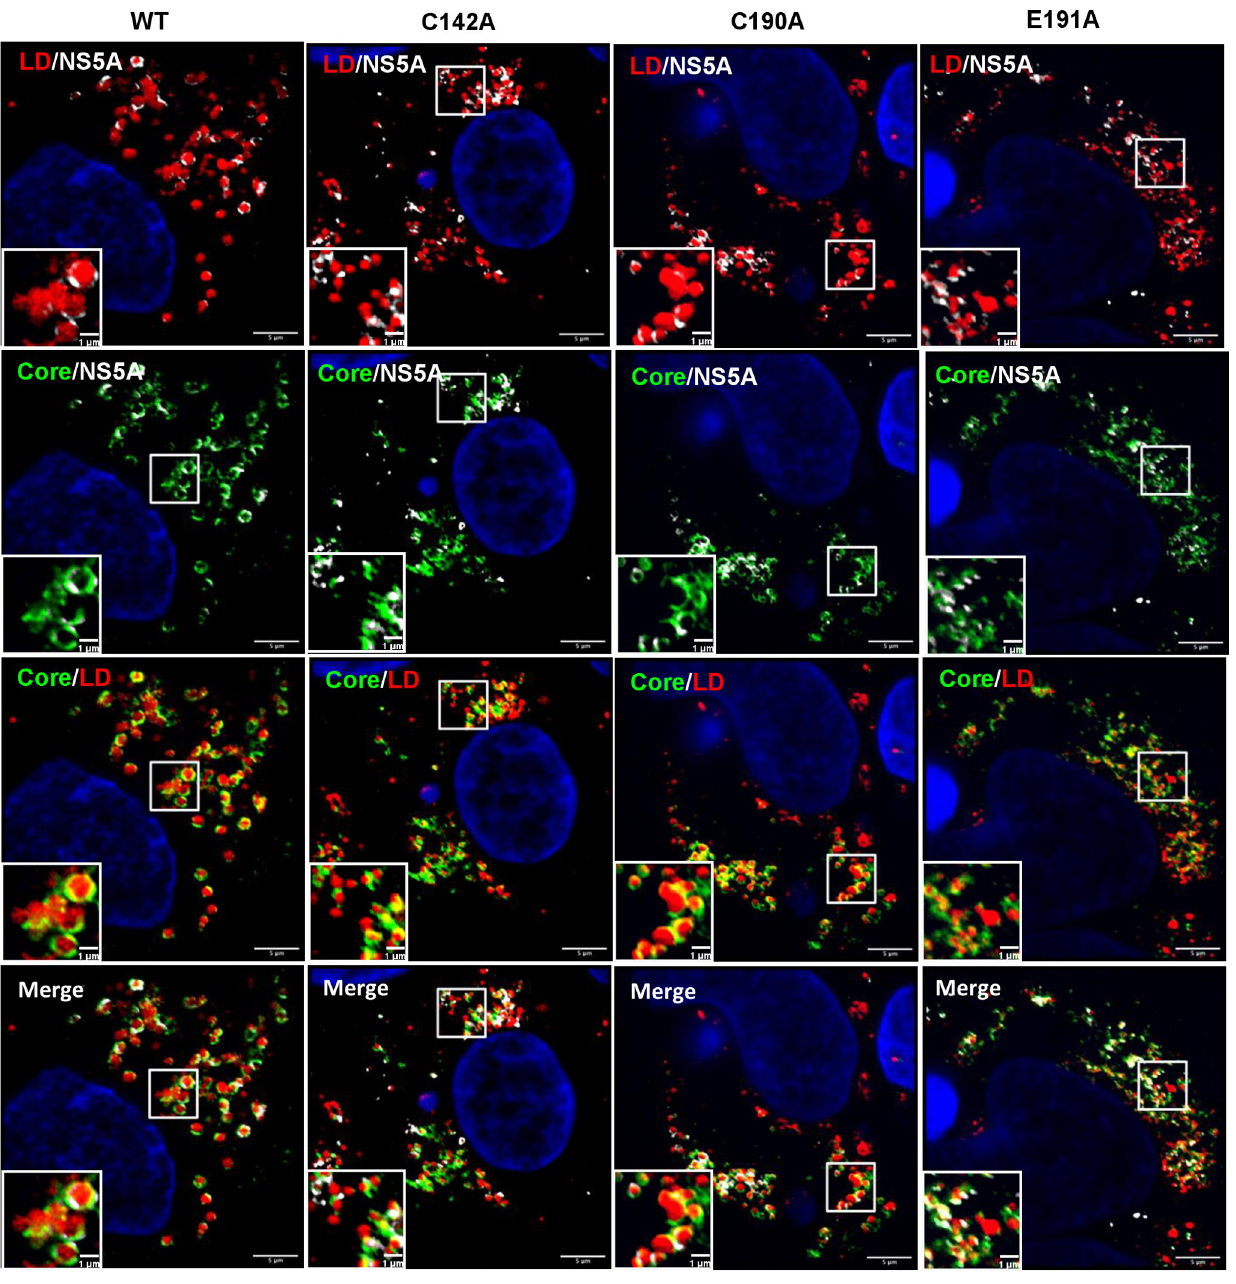
Fig 3. Co-localisation between NS5A, Core and LD. Huh7.5 cells were electroporated with mJFH-1 WT and DI mutant C142A, C190A and E191A RNAs and seeded on to coverslips. At 72 hpe cells were stained with sheep anti-NS5A (white), rabbit anti-Core (green), BODIPY 558/568-C12 (red) and DAPI. Co-localisation was observed using Airyscan microscopy. Representative images are presented. A representative image of mock electroporated cells is shown in S6A Fig. Scale bars are 5 μ m and 1 μ m (insets).